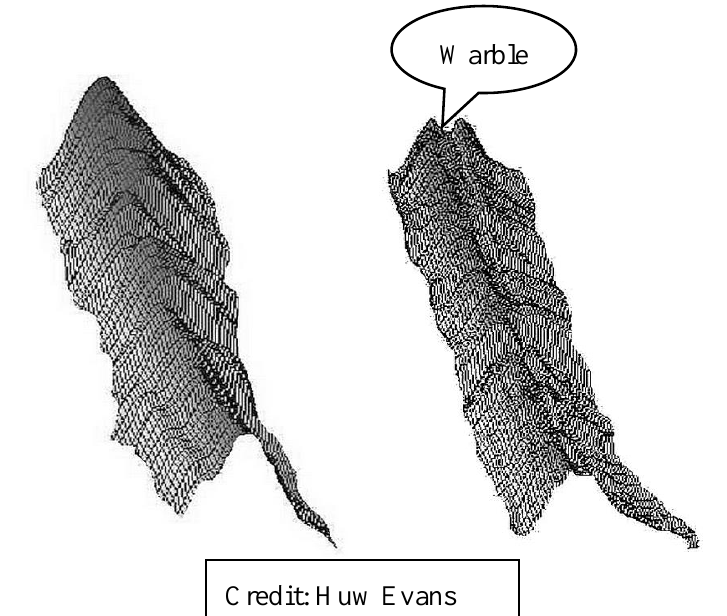
Figure 11. Arnia’s Remote Hive Monitoring. Normal sonogram (L.), swarming warble (R)